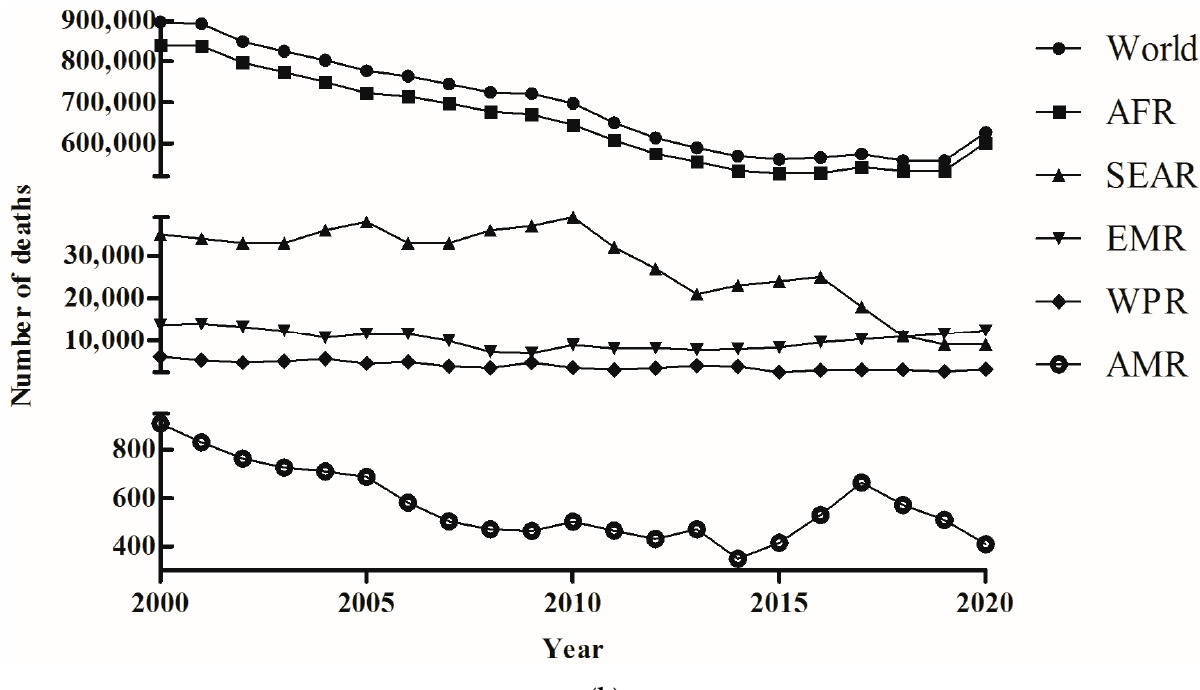
Figure 2. Geographic distribution of the number of cases ( a ) and deaths ( b ) of malaria globally dur- ing 2000–2020.